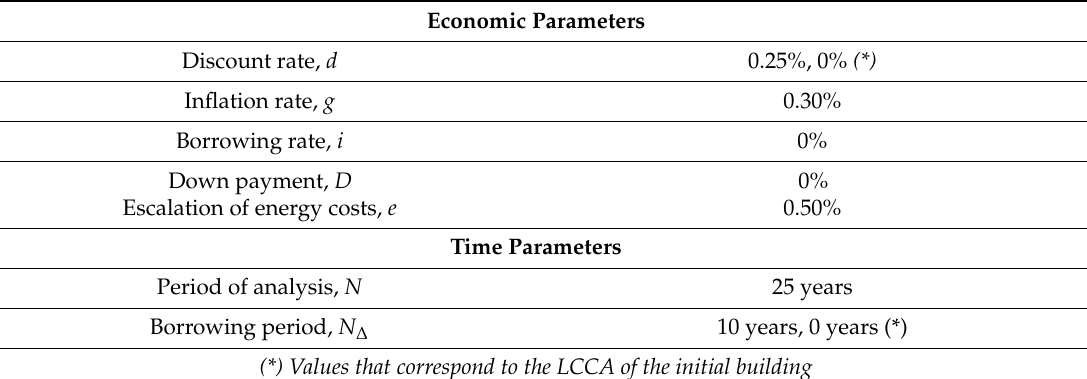
Table 5. Economic and time parameters for the calculation method of